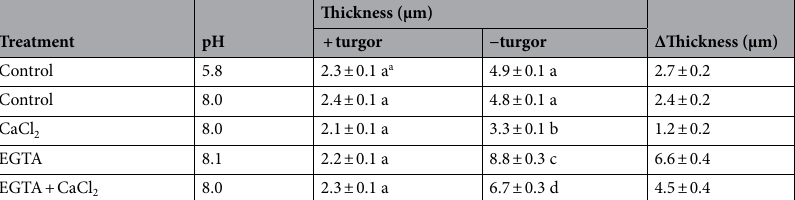
Table 3. Effects of CaCl 2 (5 mM), EGTA (5 mM) or CaCl 2 (2.5 mM) plus EGTA (2.5 mM) on thickness and swelling (Δthickness) of anticlinal epidermal cell walls of excised skin segments (ES) of ‘Burlat’ sweet cherry fruit before (+ turgor) and after turgor release (−turgor) by a freeze/thaw cycle. All solutions were buffered with 10 mM MES and pH adjusted with KOH to 8.0. MES at pH 5.8 and pH 8.0 served as controls. ΔThickness was calculated as the difference between the thickness measured after turgor release minus that measured before turgor release. Data are means ± SE. a Mean separation within columns, Tukey’s Studentized range test at p < 0.05.